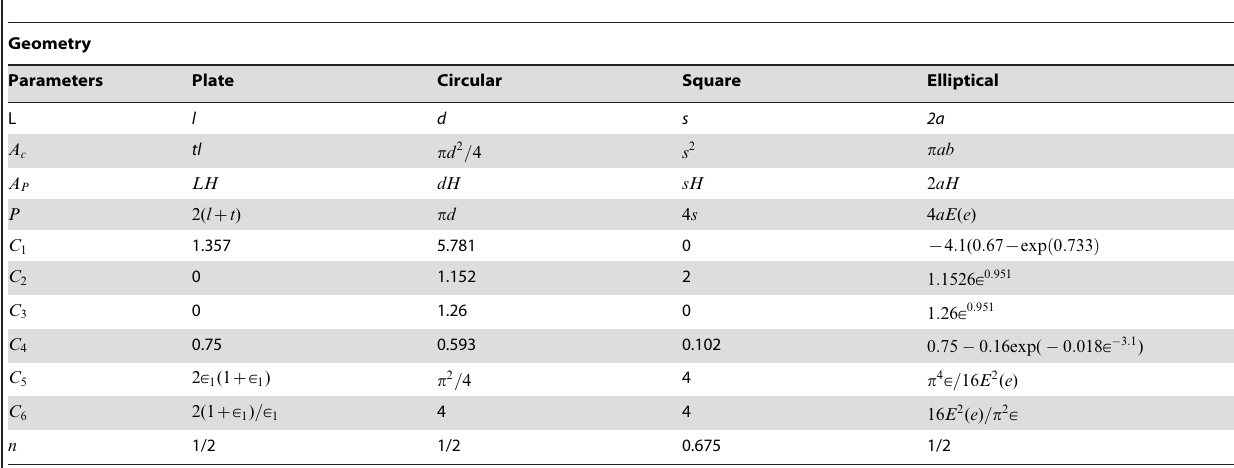
Table 1. Parameters for different